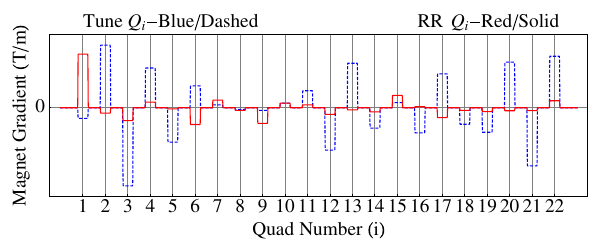
FIG. 7. Magnet settings at the end of the iterative tuning scheme compared to 2011 tune up